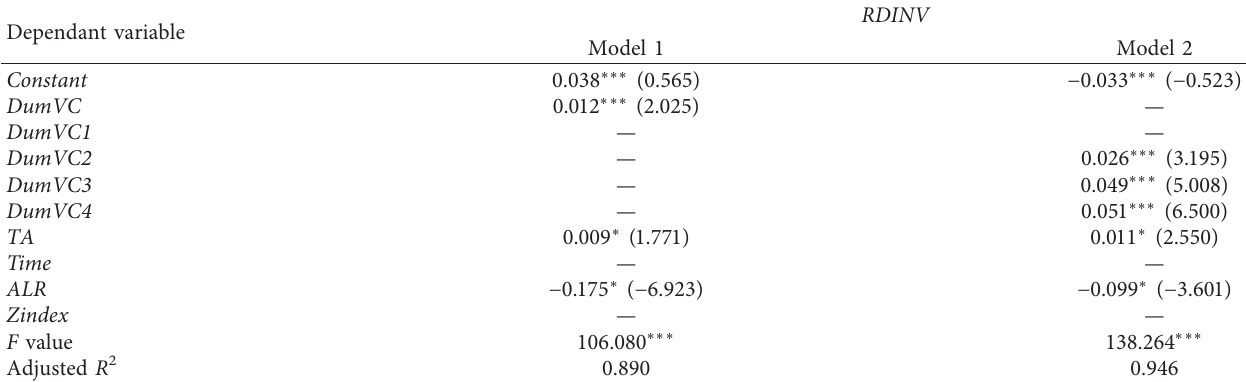
Table 2: Effects of venture capital on the technological innovation of SMEs.